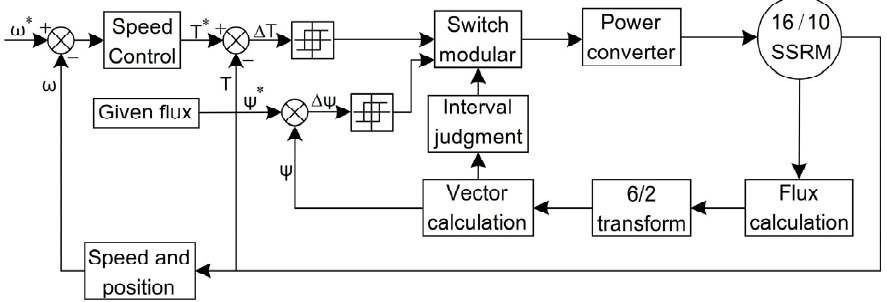
Figure 12. Control block diagram of the DTC system of 16/10 SSRM. Notes: ψ is given flux; ψ * is the actual flux.